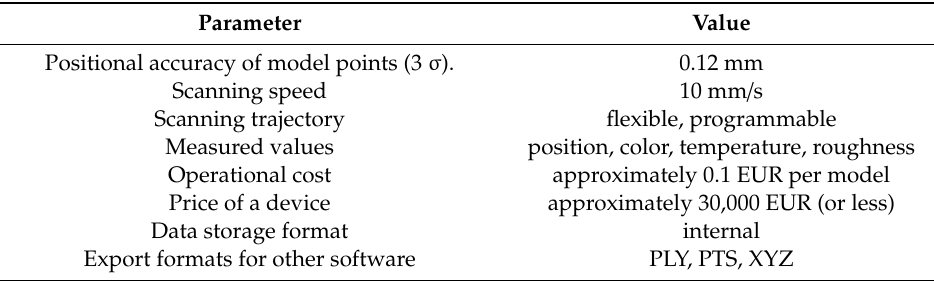
Table 1. The key